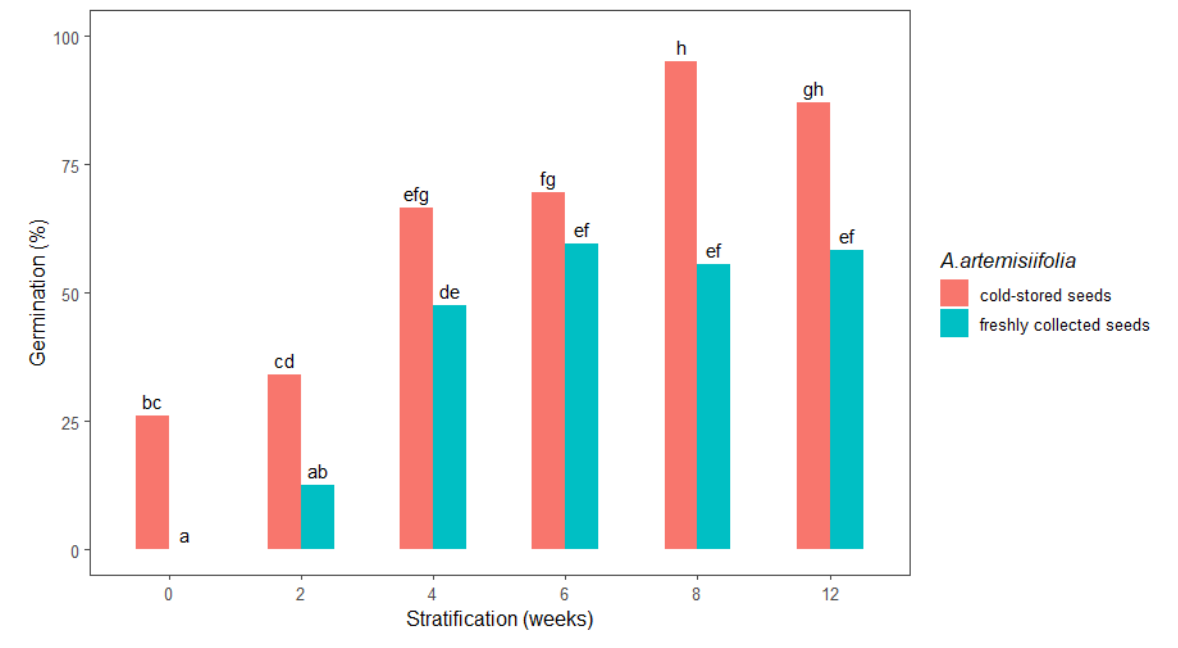
Figure 2. Total germination 14 days after sowing of freshly collected or cold-stored Ambrosia artemisiifolia seeds at different stratification intervals (0, 2, 4, 6, 8, and 12 weeks). The estimated marginal means of eight replicates are shown (standard error = 4.49). Means following the same letter are not significantly different ( p < 0.05) according to Tukey’s test.